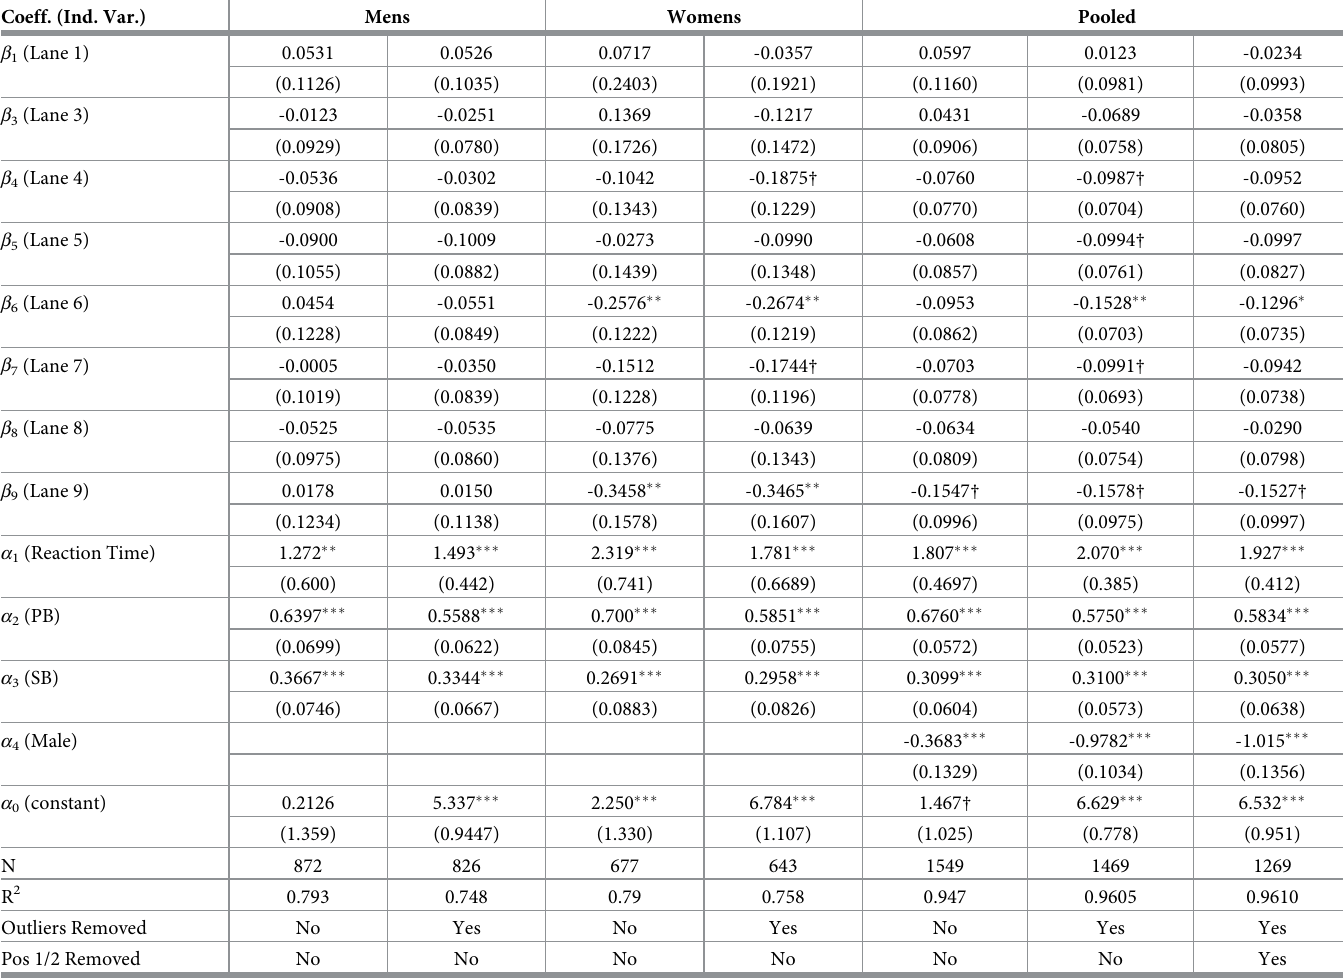
Table 4. Regression results for 400m. Coeff. (Ind.